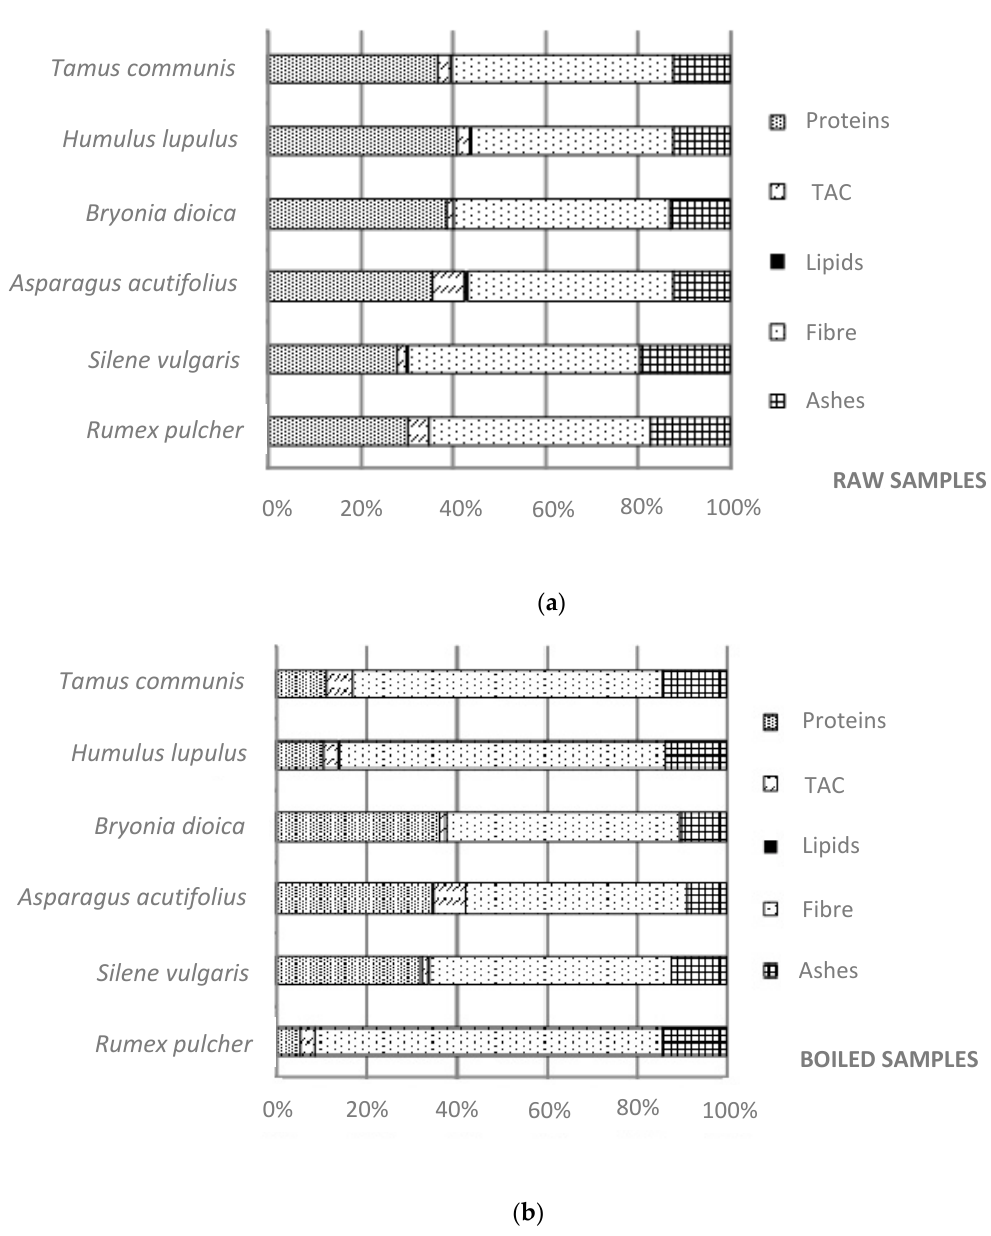
Figure 1. Proximate composition ( a ) before and ( b ) after boiling process in the wild edible greens selected (g/100 g dry basis).